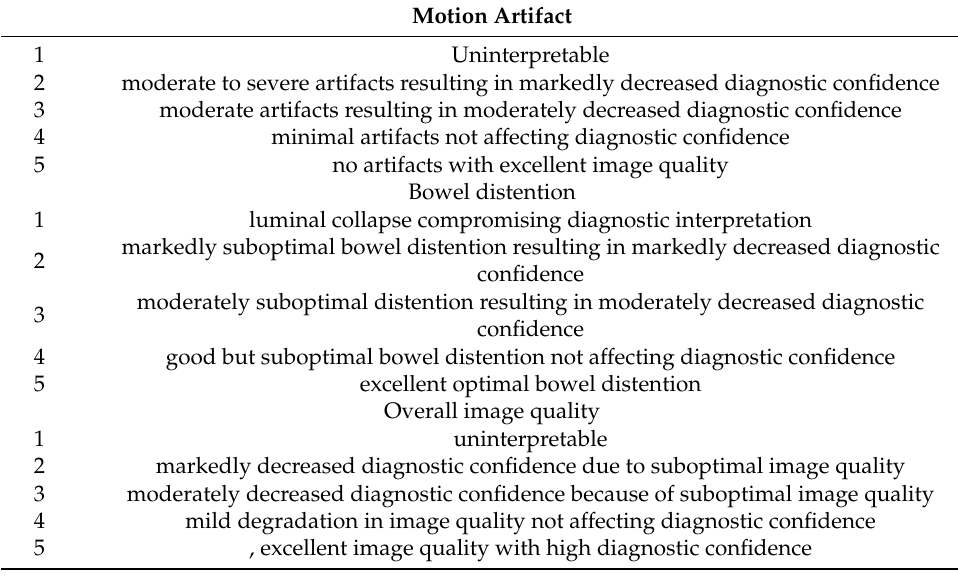
Table A3. Assessment form of image quality